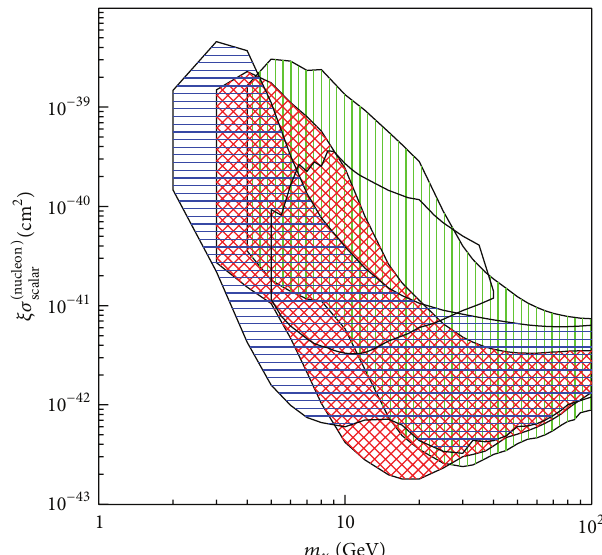
Figure 9: Regions in the nucleon cross section versus DM particle mass plane allowed by DAMA for a DM candidate interacting via spin- independent elastic scattering on target-nucleus; three different instances for the Na and I quenching factors have been considered: (i) without includingthechannelingeffect [ (green)verticallyhatchedregion ] ,(ii)byincludingthechannelingeffect [ (blue)horizontallyhatchedregion) ] , and (iii) without the channeling effect considering energy dependence of Na and I quenching factors [5] [ (red) crosshatched region ] . The velocity distributions and the same uncertainties as in [23, 24] are considered here. These regions represent the domain where the likelihood- function values differ more than 7.5𝜎 from the null hypothesis (absence of modulation). The allowed region obtained for the CoGeNT experiment, including the same astrophysical models as in [23, 24] and assuming for simplicity a fixed value for the Ge quenching factor and a Helm form factor with fixed parameters, is also reported by a (black) thick solid line. This region includes configurations whose likelihood- function values differ more than 1.64𝜎 from the null hypothesis (absence of modulation). For details, see [5].